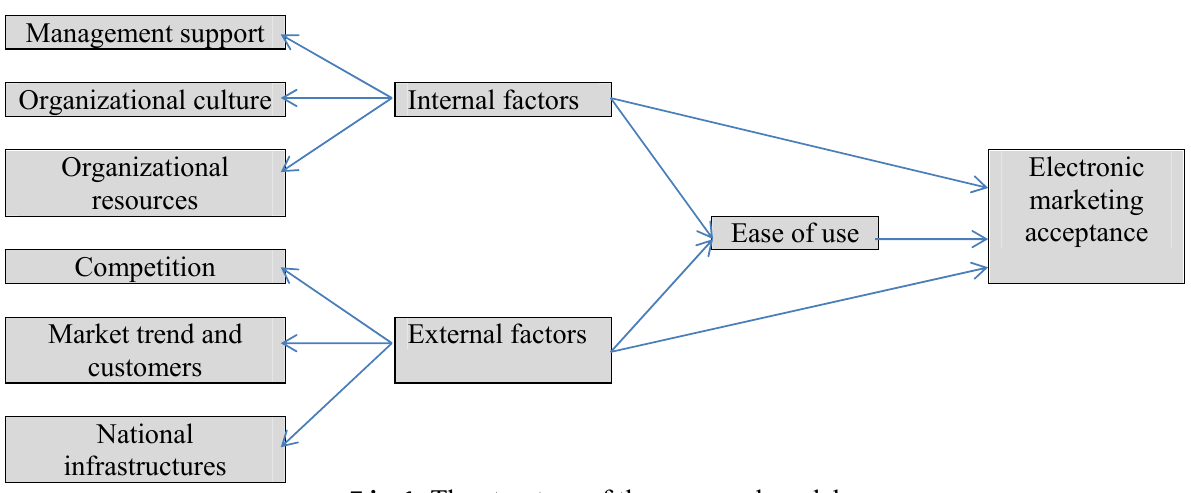
Fig. 1. The structure of the proposed